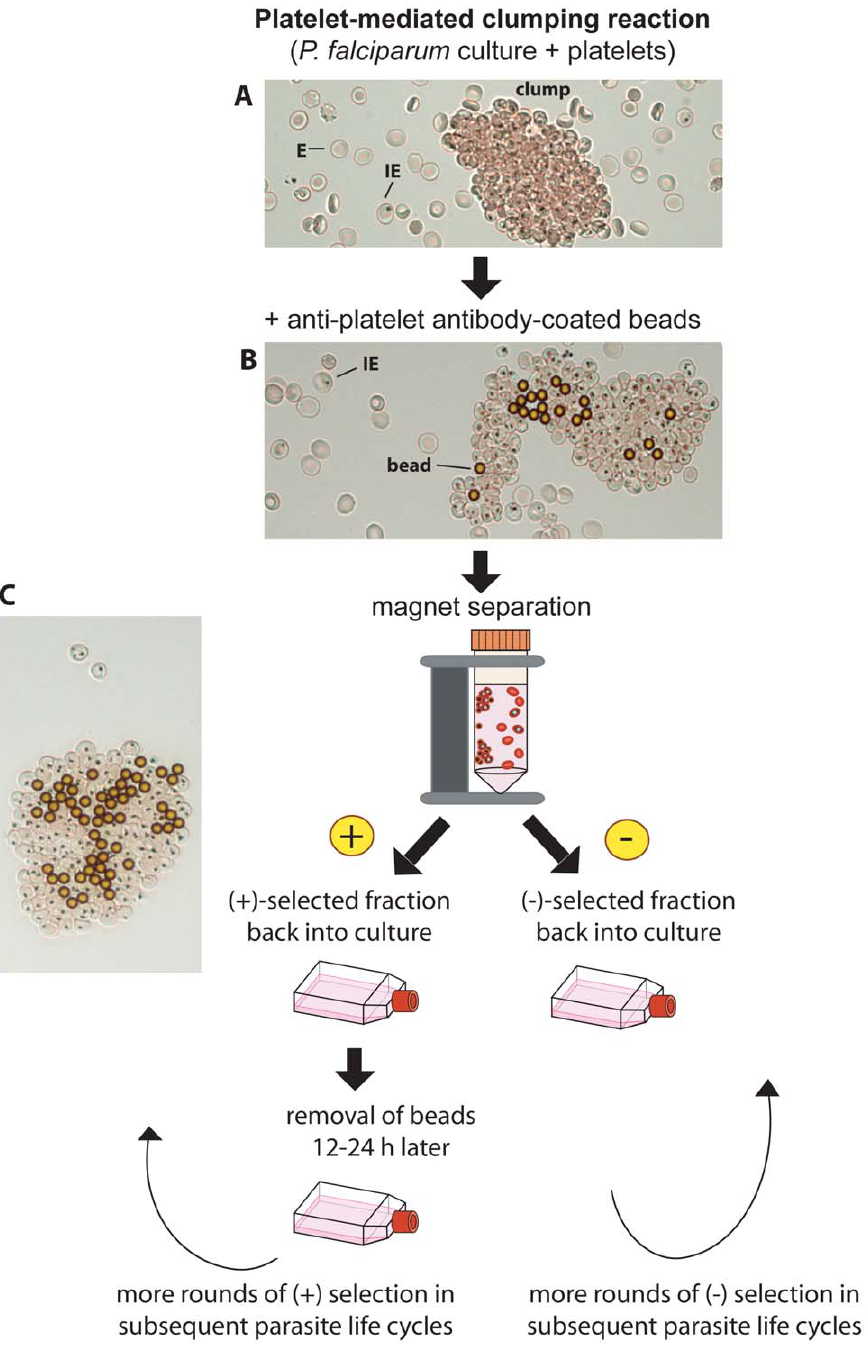
Figure 1. Schematic diagram of positive and negative selection for P.falciparum platelet-mediated clumping. (A) A platelet-mediated clumping assay is carried out in sterile conditions by co-incubating an unstained mature pigmented trophozoite-stage P. falciparum culture with platelets in suspension. The presence of clumps is confirmed by viewing a wet preparation of parasite culture suspension using bright-field microscopy (400 6 magnification). Infected erythrocytes (IEs) can be distinguished from erythrocytes (Es) by the presence of pigment (black dots) in IEs that corresponds to the parasite-generated haemozoin. The platelets cannot be seen in these unstained preparations (for visualization of platelets in clumps see references [1,2]). (B) Magnetic beads coated with an anti-platelet antibody are added to the suspension and become bound to the platelets within the clumps. Binding of beads is confirmed by viewing a wet preparation of parasite culture suspension using bright-field microscopy (400 6 magnification). (C) A magnet is applied to separate beads and bead-bound clumps (positive fraction, bound to the magnet) from non- clumping IEs and Es (negative fraction, remaining in the supernatant). Each fraction is washed and transferred to a new flask with fresh uninfected Es added as required. The beads can be magnetically separated from the positive fraction the following day after the parasites have invaded fresh E to become non-adherent ring stages. The clumping frequency (CF) of the selected populations can be tested in the next cycle, with further rounds of ( + ) or ( 2 ) selection being performed as required.